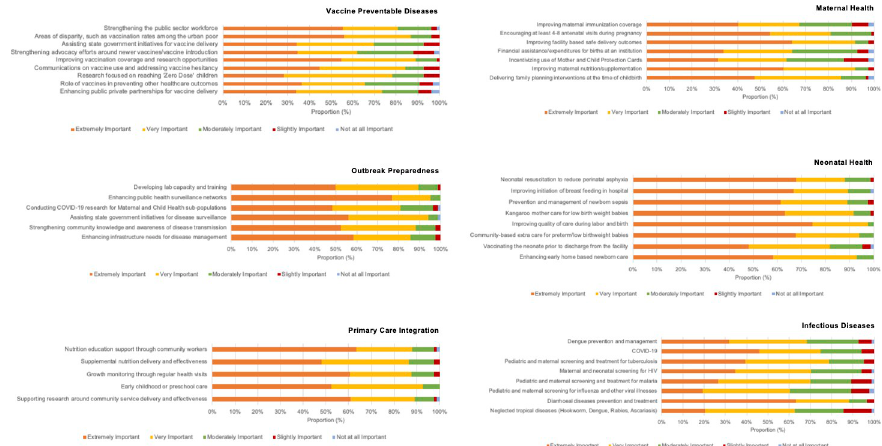
Fig 1. Level of importance assigned to individual sub-domain research priorities by respondents across six domains of maternal and child health (n = 84). Legend: In a rapid survey conducted to identify the top priorities in maternal and child health research in India during the COVID-19 pandemic, it was found that across the six identified domains, priorities related to systems strengthening received high levels of importance, as seen in this Likert scale